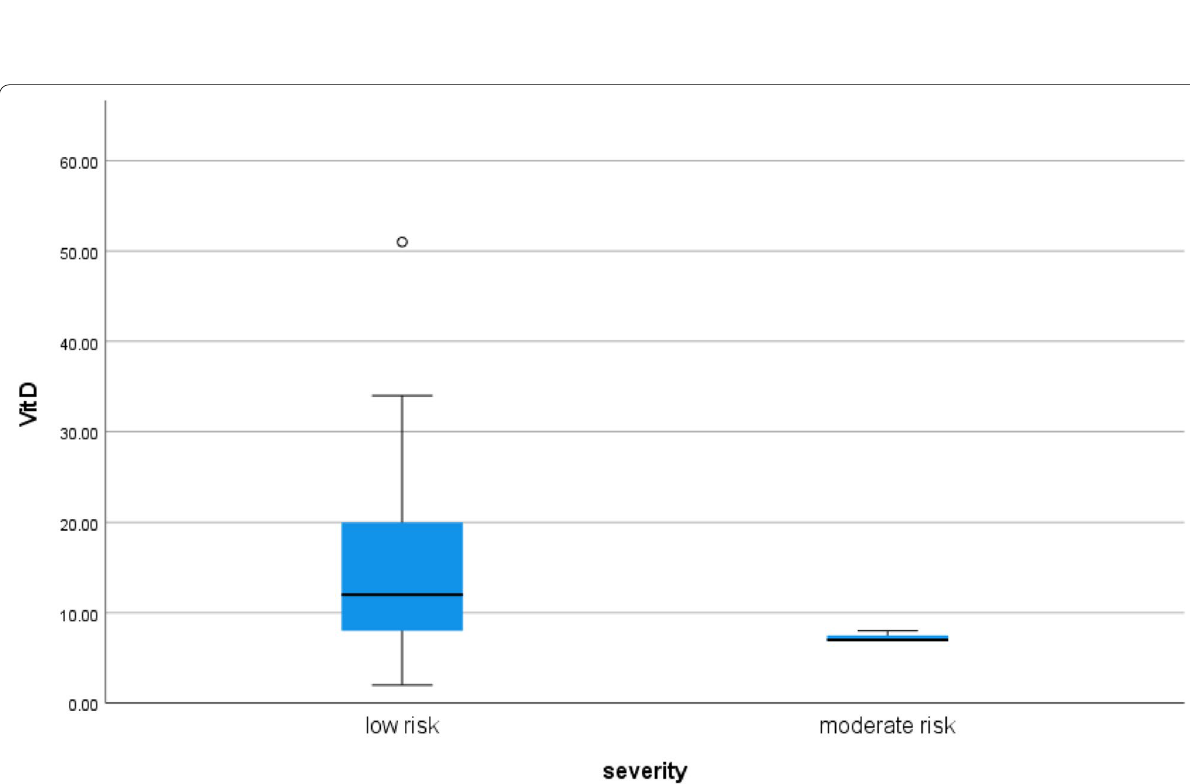
Fig. 20 Correlation between serum vitamin D level and the severity of symptoms in COVID 19 patients (symptomatic and